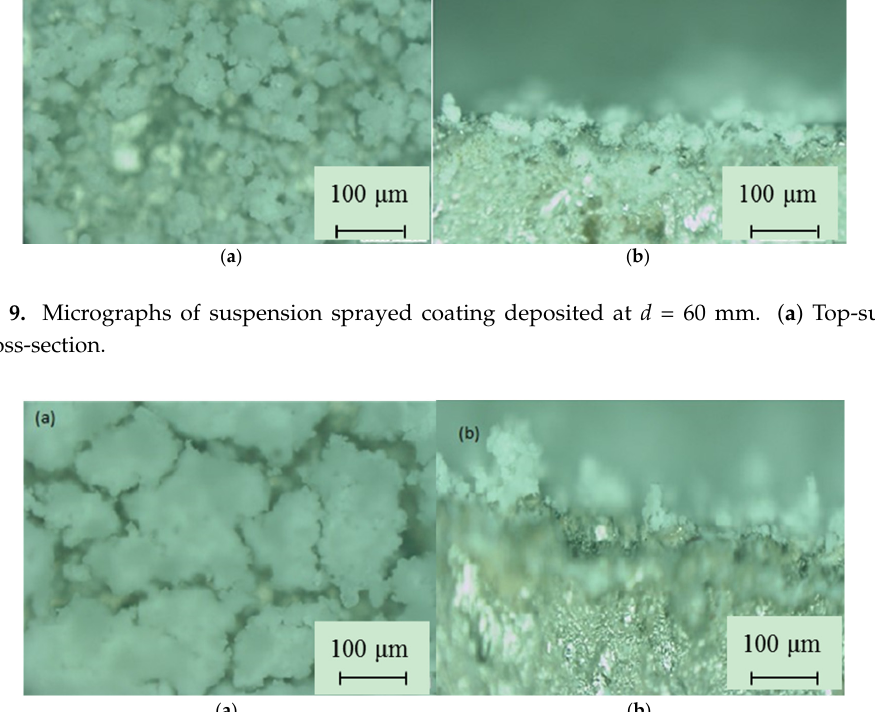
Figure 10. Micrographs of suspension sprayed coating deposited at d = 80 mm. ( a ) Top ‐ surface; ( b ) Cross ‐ section.